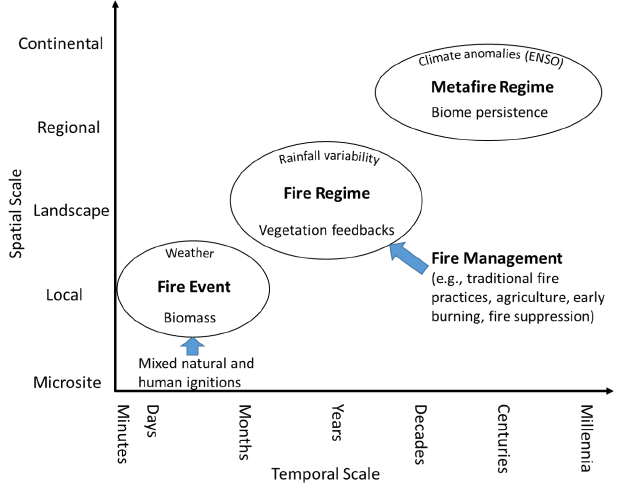
Fig. 1 . Controls of fire at multiple spatial and temporal scales, including the role of humans in shaping fire dynamics (adapted from Whitlock et al. 2010, Bowman et al. 2011). ENSO, El Niño–Southern